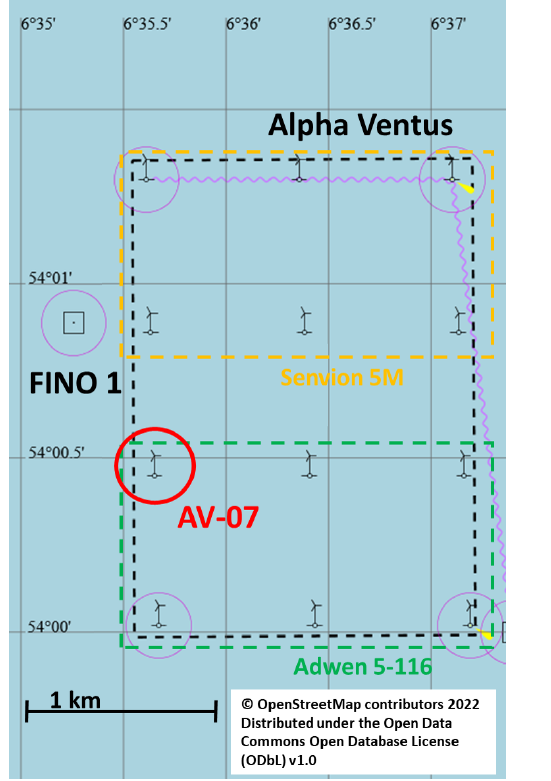
Figure 1. Farm layout of Alpha Ventus with the considered AV-07 turbine marked (adapted from